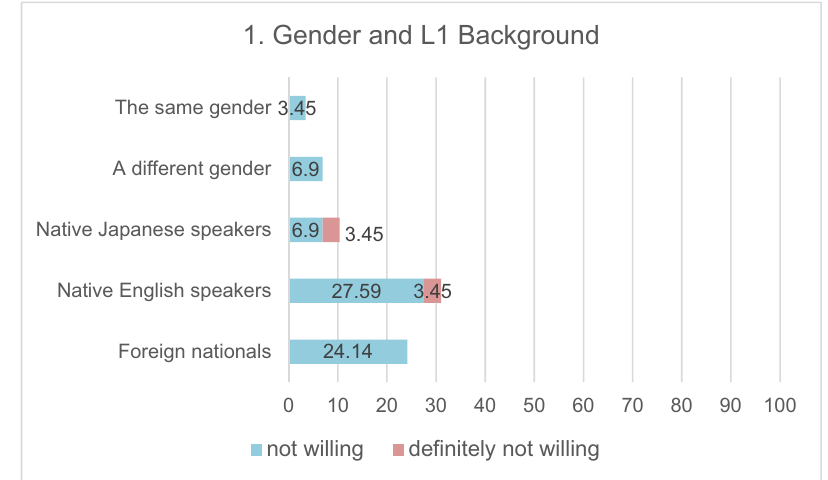
Figure 13: Unwillingness rates under di ff erent Interlocutors in L2 ( % )